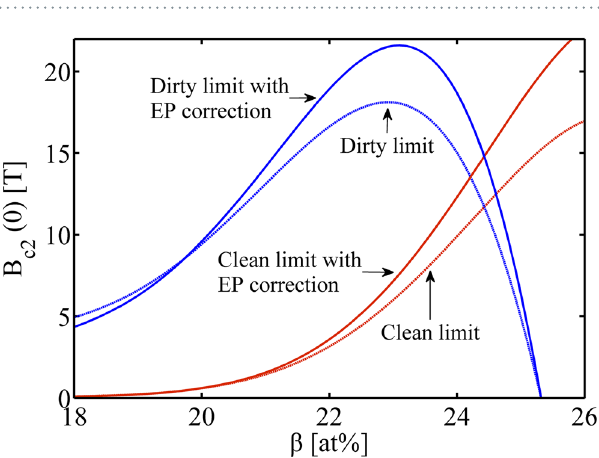
Figure 4. Upper critical field B c2 variation as a function of tin content β at: the vicinity of T c (Top) and 0K temperature (Bottom). MDG: extrapolation of H c2 ( T c ) with MDG relation, Eqs. (1), (2) and (8); EP + MDG: extrapolation of EP corrected H c2 ( T c ) with MDG, Eqs. (1), (2), (3) and (8); PPL: Pauli paramagnetic limit, Eqs. (1) and (10); EP + PPL: EP corrected Pauli paramagnetic limit, Eqs. (1) and (11); □ : Experiment dataset-1 3 ; △ : Experiment dataset-2 11 .